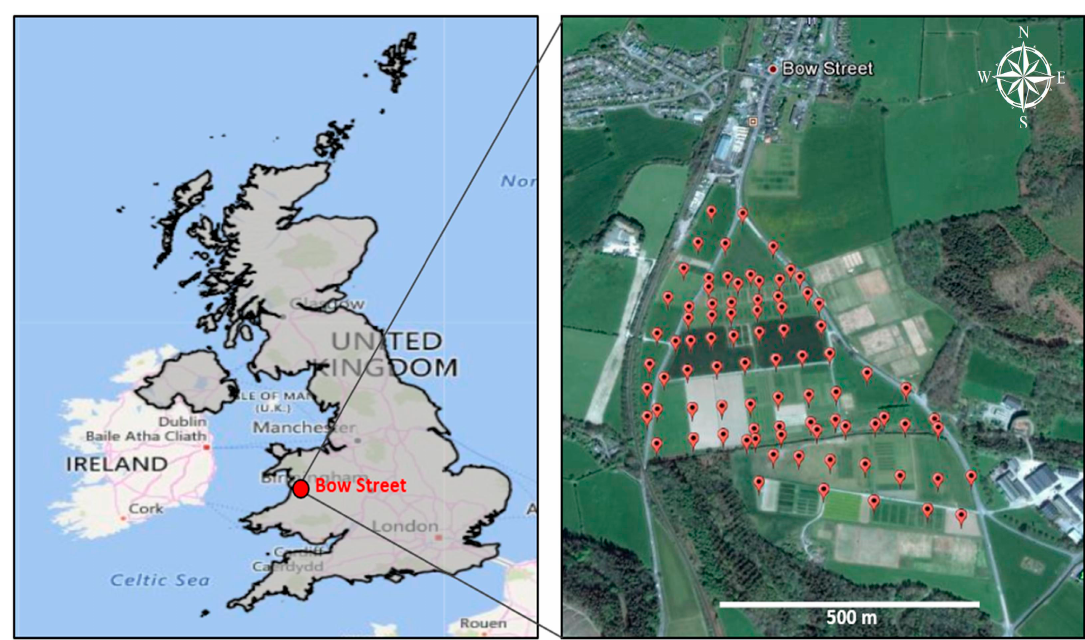
Figure 1. Geographical position of the study area and locations of the 85 sampling points.